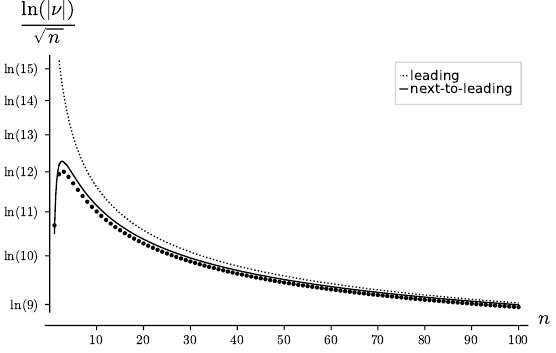
Figure 4 . Scalar charge/magnetic dipole moment ν of a critical vortex obtained from the numerical solution of the exact vortex equations (black dots), the asymptotic result eq. (2.14) (dotted line), and the next-to-leading approximation (solid line) as functions of the winding number n .